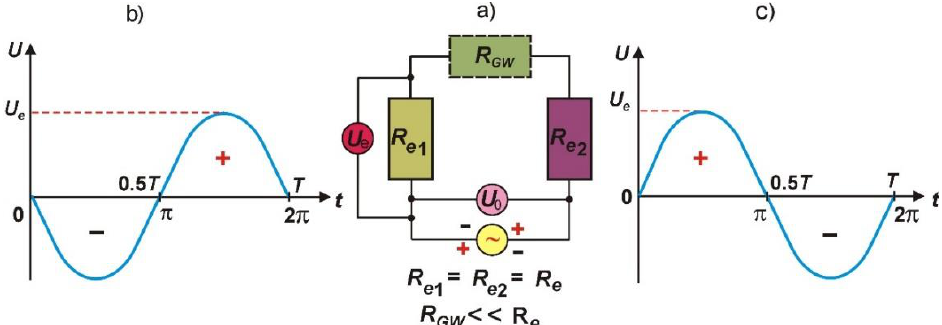
Figure 2. ( a ) Equivalent electric circuit diagram of the dressing process using ECDGW-AC method; ( b , c ) Course of current variation on electrodes; R e — resistance of electrolyte, R GW — resistance of grinding wheel.